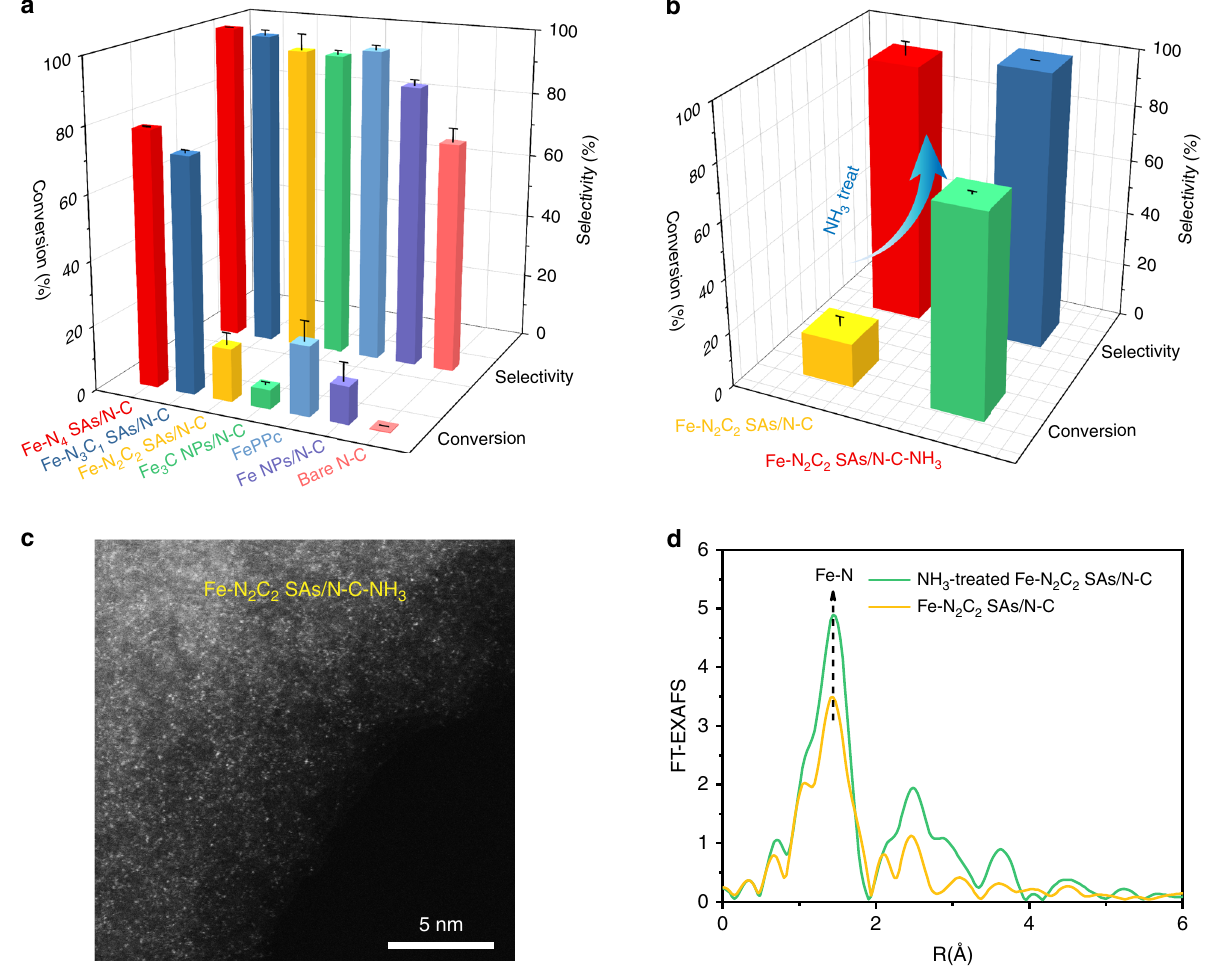
Fig. 3 BOR performance and structure analysis. a Comparison of BOR performance of the as-synthesized different catalysts at 30 °C for 24 h. b Comparison of BOR performance of Fe-N 2 C 2 SAs/N-C catalyst before and after NH 3 treatment at 30 °C for 24 h. The error bars represent the standard deviation of three measurements. c AC-HAADF-STEM image of the Fe-N 2 C 2 SAs/N-C-NH 3 . Scale bar, 5 nm. d FT k 3 -weighted χ (k)-function of the EXAFS spectra of the Fe-N 2 C 2 SAs/N-C catalyst before and after NH 3